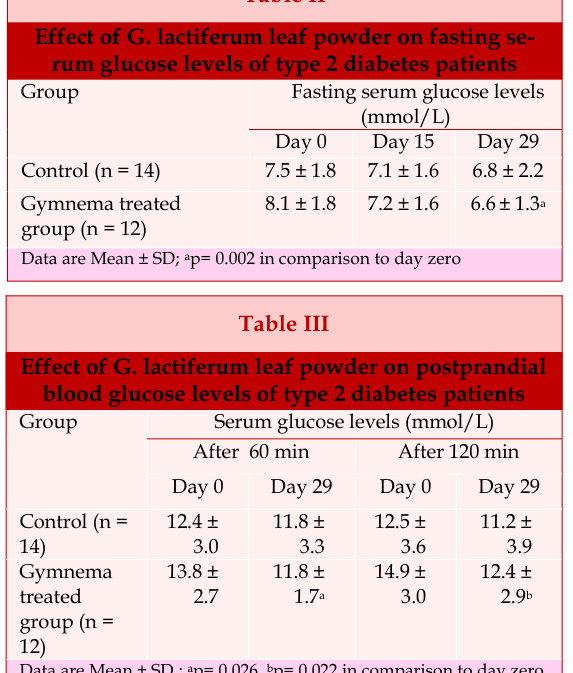
Effect of G. lactiferum leaf powder on fasting se-